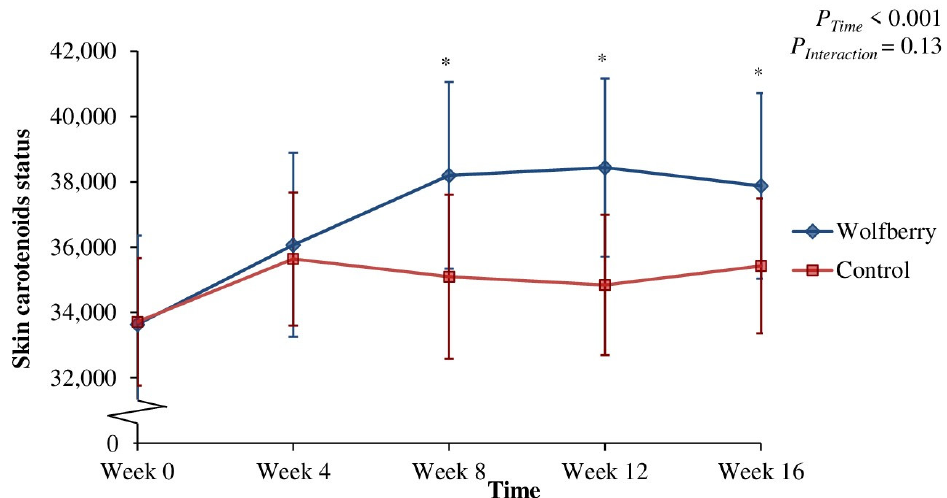
Figure 3. Skin carotenoids status for wolfberry group ( n = 22) and control group ( n = 18) at 4-week intervals of randomized controlled trial. Values are means with error bars representing the corresponding standard errors of mean. Data analyzed with two-way mixed model ANOVA and post-hoc simple effects test by Bonferroni’s multiple contrasts. * p < 0.05 compared to the corresponding week 0 values. Skin carotenoids status was not significantly different between groups at week 0 according to independent t-tests ( p = 0.98).